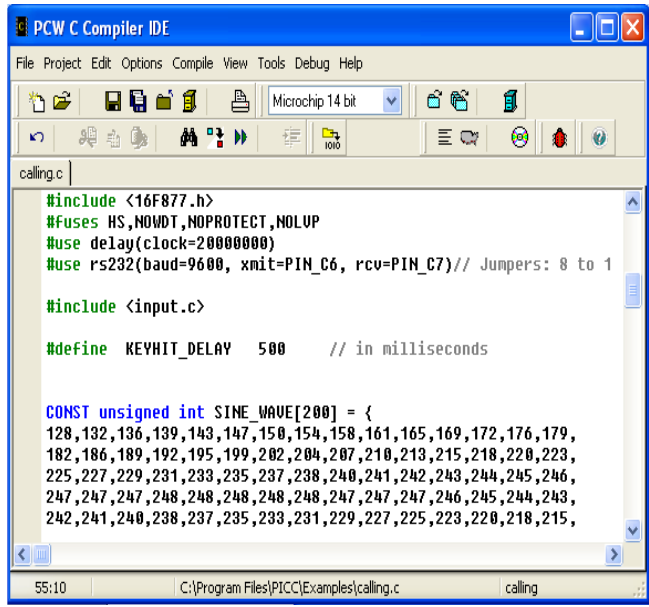
Figure 10: PCW C